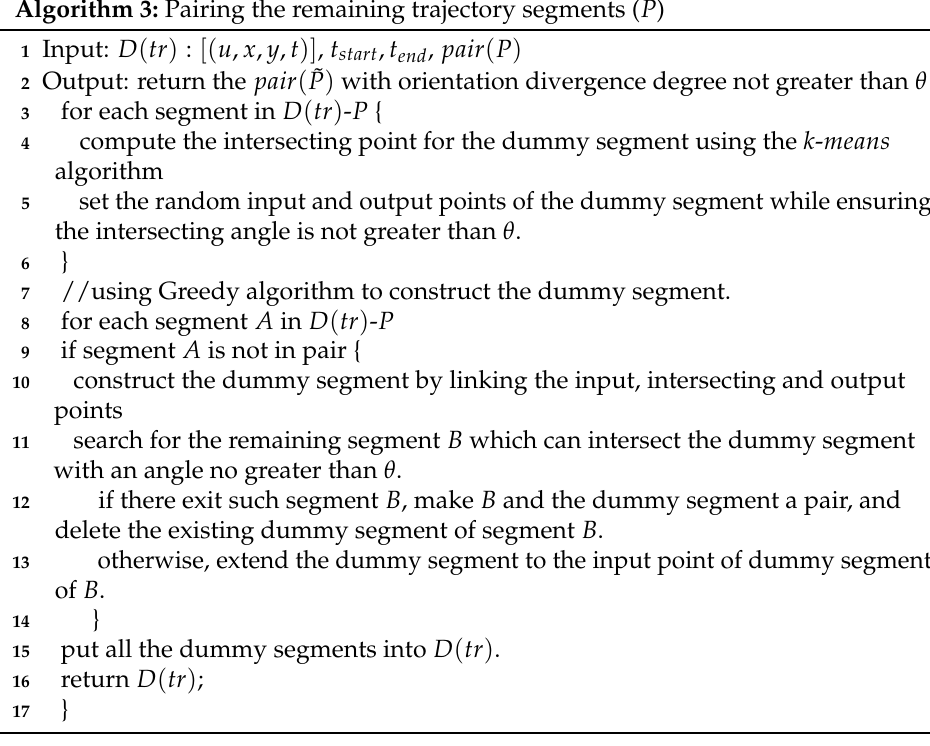
Algorithm 3: Pairing the remaining trajectory segments ( ˜ P )